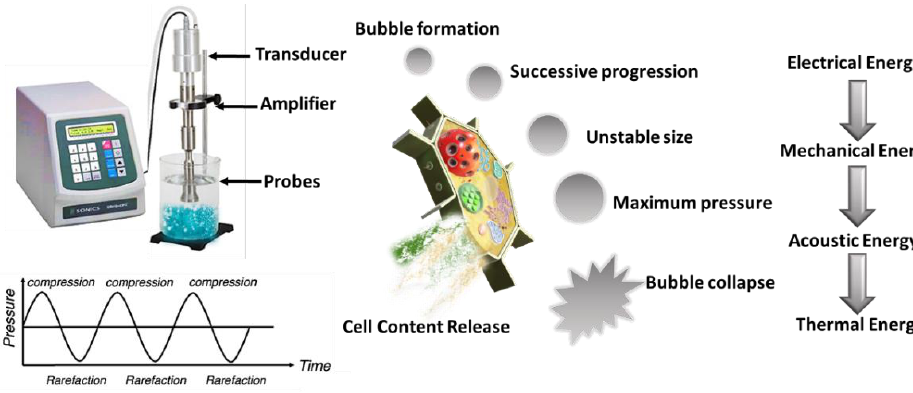
Figure 6. Schematic representation of ultrasound technology and its effect on plant